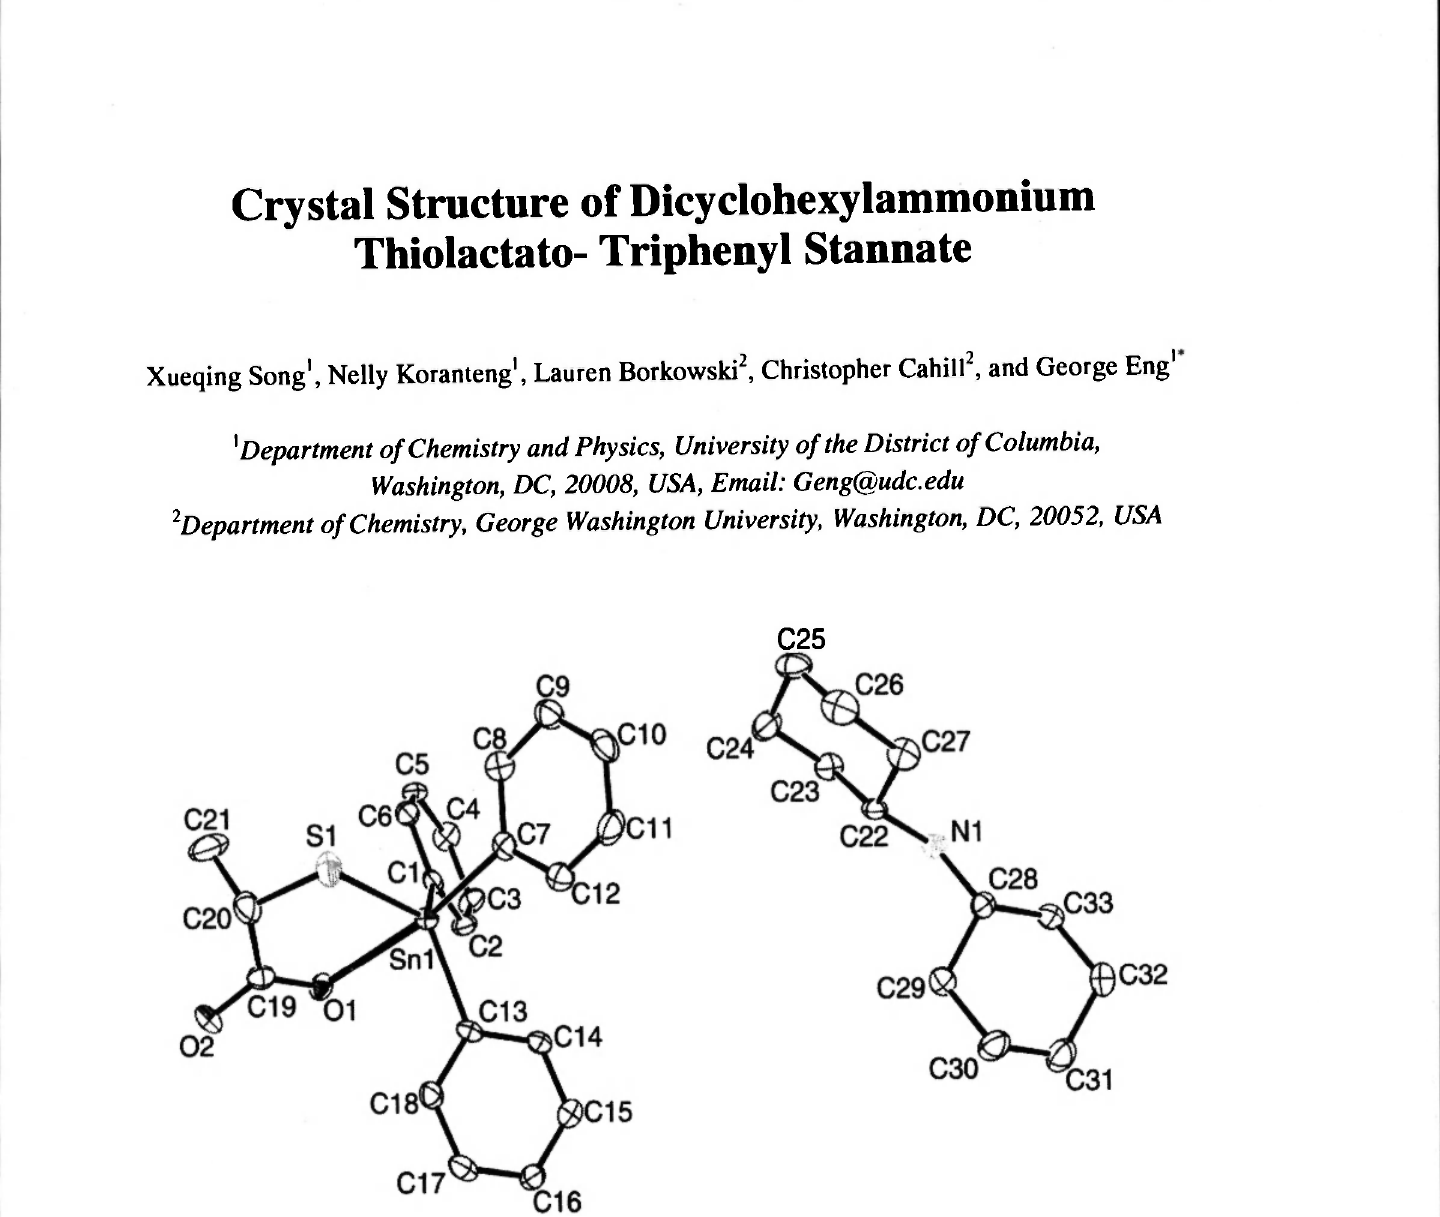
Figure 1: Molecular structure of [Ph Snl-Ol 2.498(3), Snl-Sl 2.4173(10), Snl-Cl 2.144(4), Snl-C7 2.182(4), Snl-C13 2.142(4), C19-01 1.260 (4), C19-02 1.235(5) A; Cl-Snl-C7 103.71(14), Cl-Snl-C13 111.19(14), C7-Snl-C13 103.13(14), Ol-Snl-Sl 75.89(6), Ol-Snl-Cl 83.79(11), 01-Snl-C7 167.02 (11), 01-Snl-C13 83.51(11), Sl-Snl-Cl 118.76(10), Sl-Snl-C7 91.17(10), Sl-Snl-C13 122.611(10), Nl-HB-02' 2.755(4), Nl-HIA-Ol 2.946(4), Η-atoms omitted for clarity. Symmetry code: (i) 1-x, 1-y,